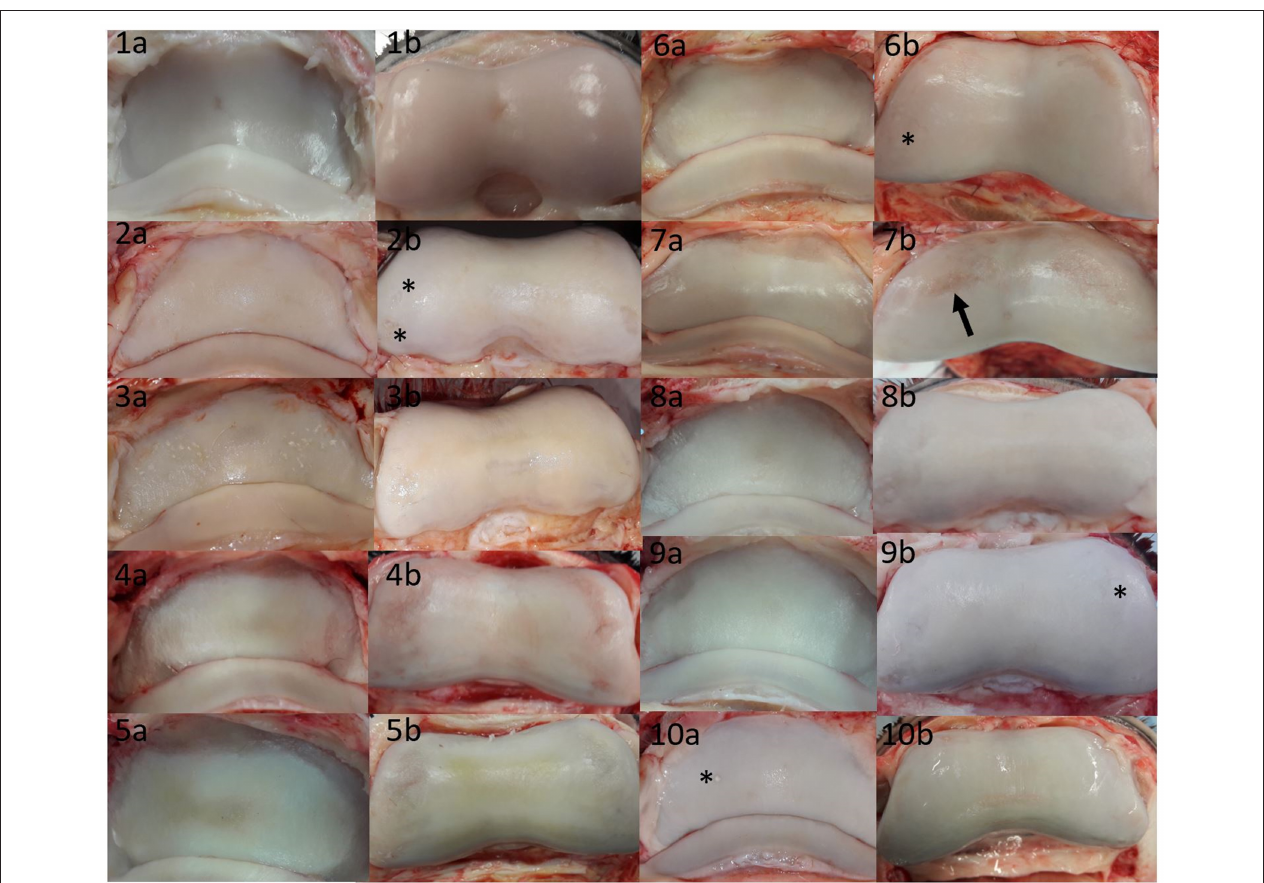
FIGURE 3 | Summary of cartilage damage that could not be identified in low-field magnetic resonance or magnetic resonance arthrography. Lateral is to the left; images labeled (a) are P3, and images labeled (b) are P2 pictures of the same joint. There was mild yellow/gray discoloration and roughening of the articular cartilage of all bones, with the exception of (1a,1b,9b,10a) . (1a) Focal grade 1 cartilage defect in axial P3; (1b) focal grade 1 cartilage defect in axial P2; (2a) mild diffuse yellow discoloration and roughening over > 50% of the articular cartilage; (2b) grade 2 cartilage defects in medial and lateral (asterisks) P2; (3a) grade 2 defects in P3 medially and laterally [note that in the contralateral limb with similar changes, signal changes could be seen on MR ( Figure 4 )]; (3b) grade 2 defects on the axial and medial surfaces of P2; (4a) grade 2 defect in P3 medially and laterally; (4b) grade 2 defect in P2 medially and laterally; (5a) grade 2 circumferential sudden cartilage thinning in P3 medially, axially and laterally; (5b) grade 2 defect in P2 medially and laterally; (6a) sudden cartilage thinning medially and laterally in P3, scored as grade 2; (6b) grade 2 defect in P2 medially and laterally (asterisk); (7a) grade 2 defect in P3 spanning the transition between axial and medial; (7b) grade 2 defect in P2 medially and laterally, note that the lateral defect (arrow) could be identified in MR ( Figure 5 ); (8a) subtle grade 1 defect in P3 axially and grade 2 defects in P3 medially and laterally; (8b) grade 2 defects P2 medially and laterally; (9a) grade 2 defect in P3 laterally; (9b) grade 2 defect in P3 laterally and medially (asterisk); (10a) grade 1 mineralization defect in P3 lateral (asterisk), (10b) grade 2 defect in axial P2 (wear lines visible) surrounded by focal roughness and off-white discoloration > 50%.